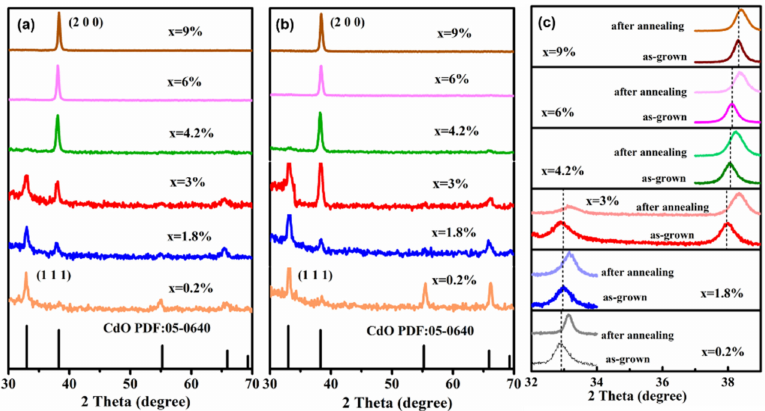
Figure 1. XRD of Cd 1 − x V x O (x = 0.2~9%): as-grown films ( a ); annealed films ( b ); comparison of as-grown and annealed films in 2 θ range of 32~39 ◦ ( c ).